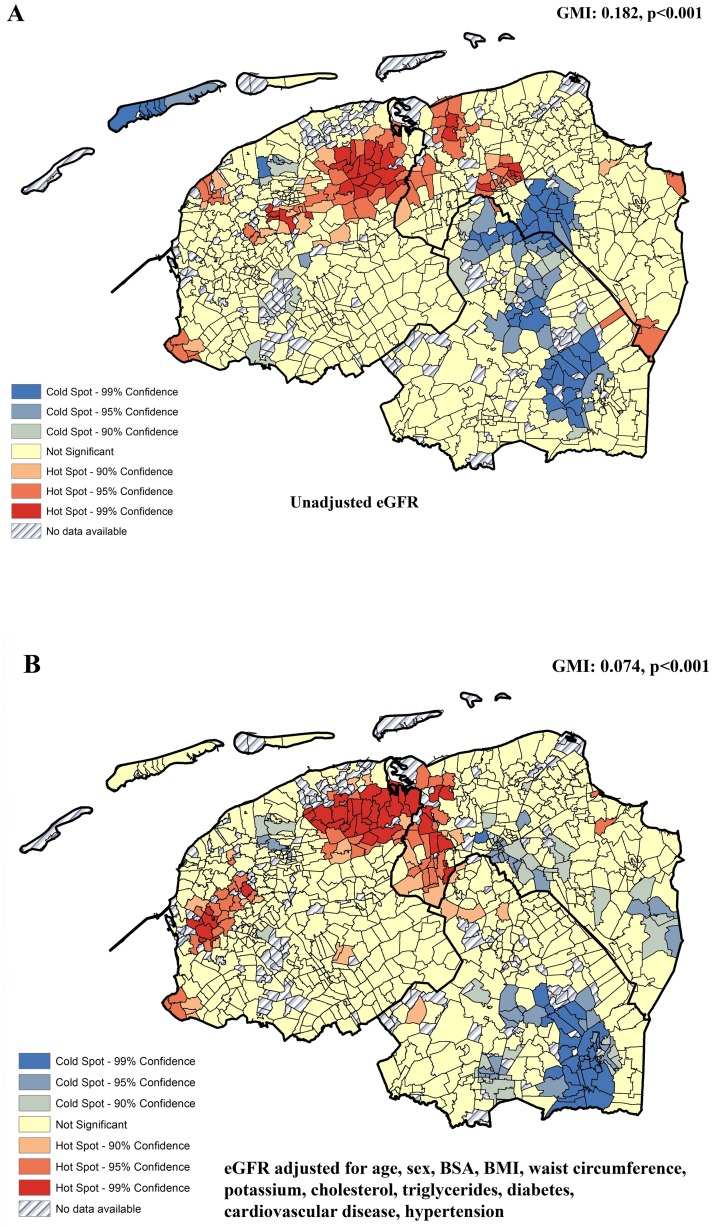
The intraregional distribution of eGFR-based renal function in Northern Netherlands.(A) Hot (red colors) and cold spot (blue colors) clusters of unadjusted eGFR. (B) Hot (red colors) and cold spot (blue colors) clusters of eGFR adjusted for known clinical risk factors, including age, sex, BSA, BMI, waist circumference, serum potassium, cholesterol, triglycerides, diabetes, cardiovascular disease and hypertension.